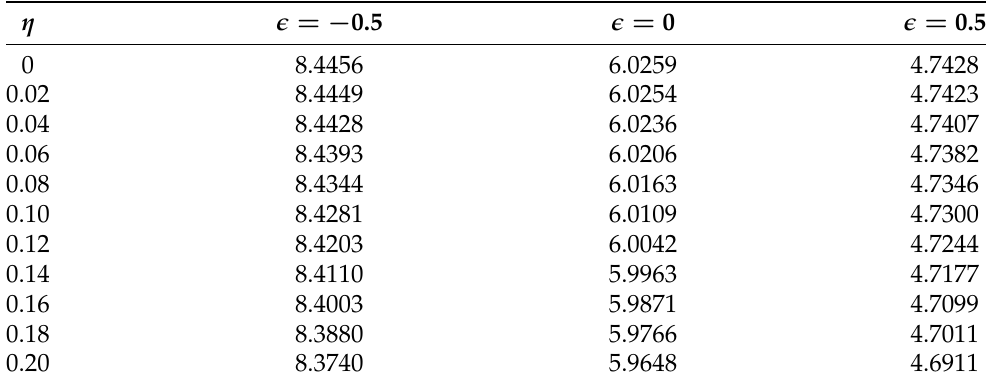
Table 4. Frequency shift ∆ f for different values of η and (cid:101) . The other parameters are q 1 = 1, q 2 = 1, λ = 0.5, K R = 0, and K T = 0.